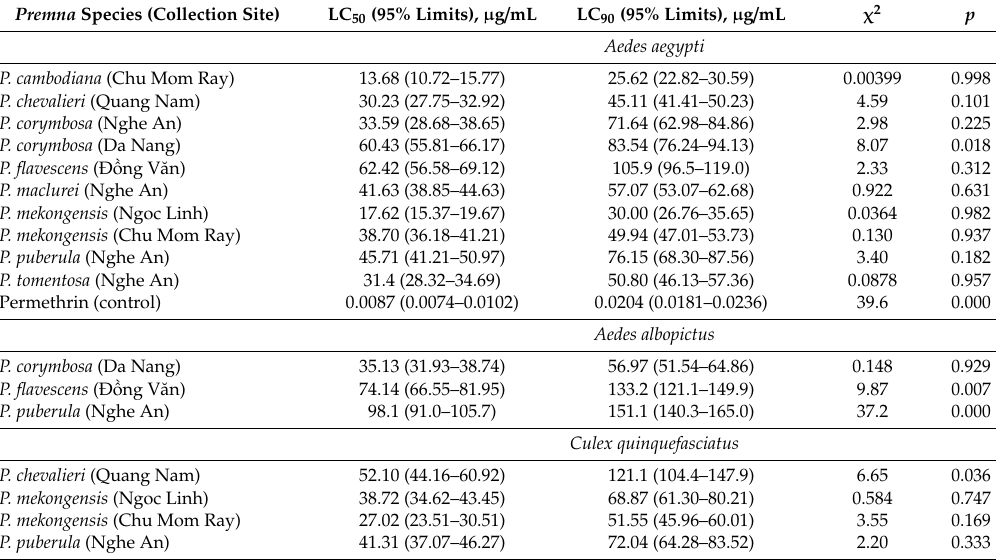
Table 5. Forty-eight-hour mosquito larvicidal activities of Premna leaf essential oils. Premna Species (Collection